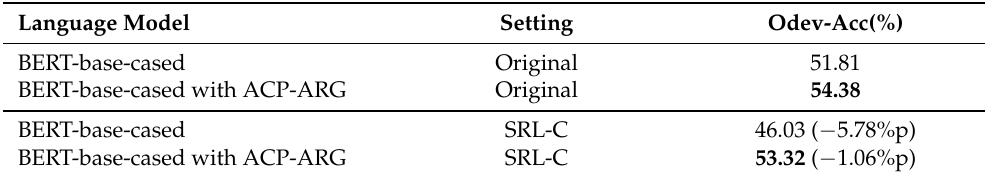
Table 3. Adversarial Attack test with Semantic Role Labeling. SRL-C denotes the setting where one distractor is replaced with the random argument in the AMR graph.